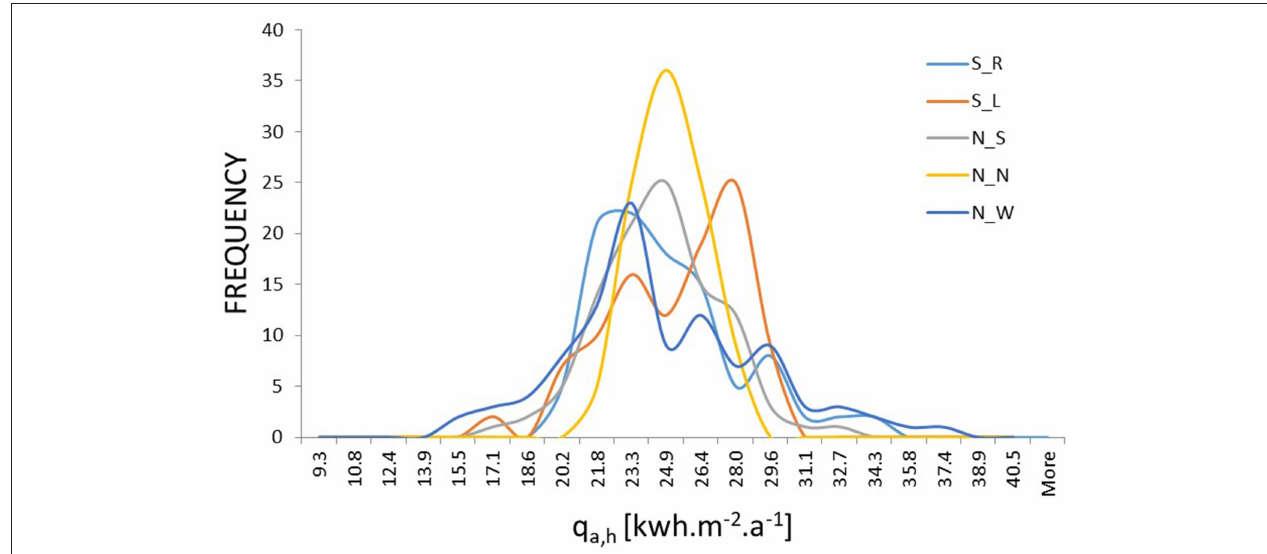
Figure 5 . The question is, what constitutes the informational value of these very different distributions for those who are meant to interpret and utilize the simulation results? In the present